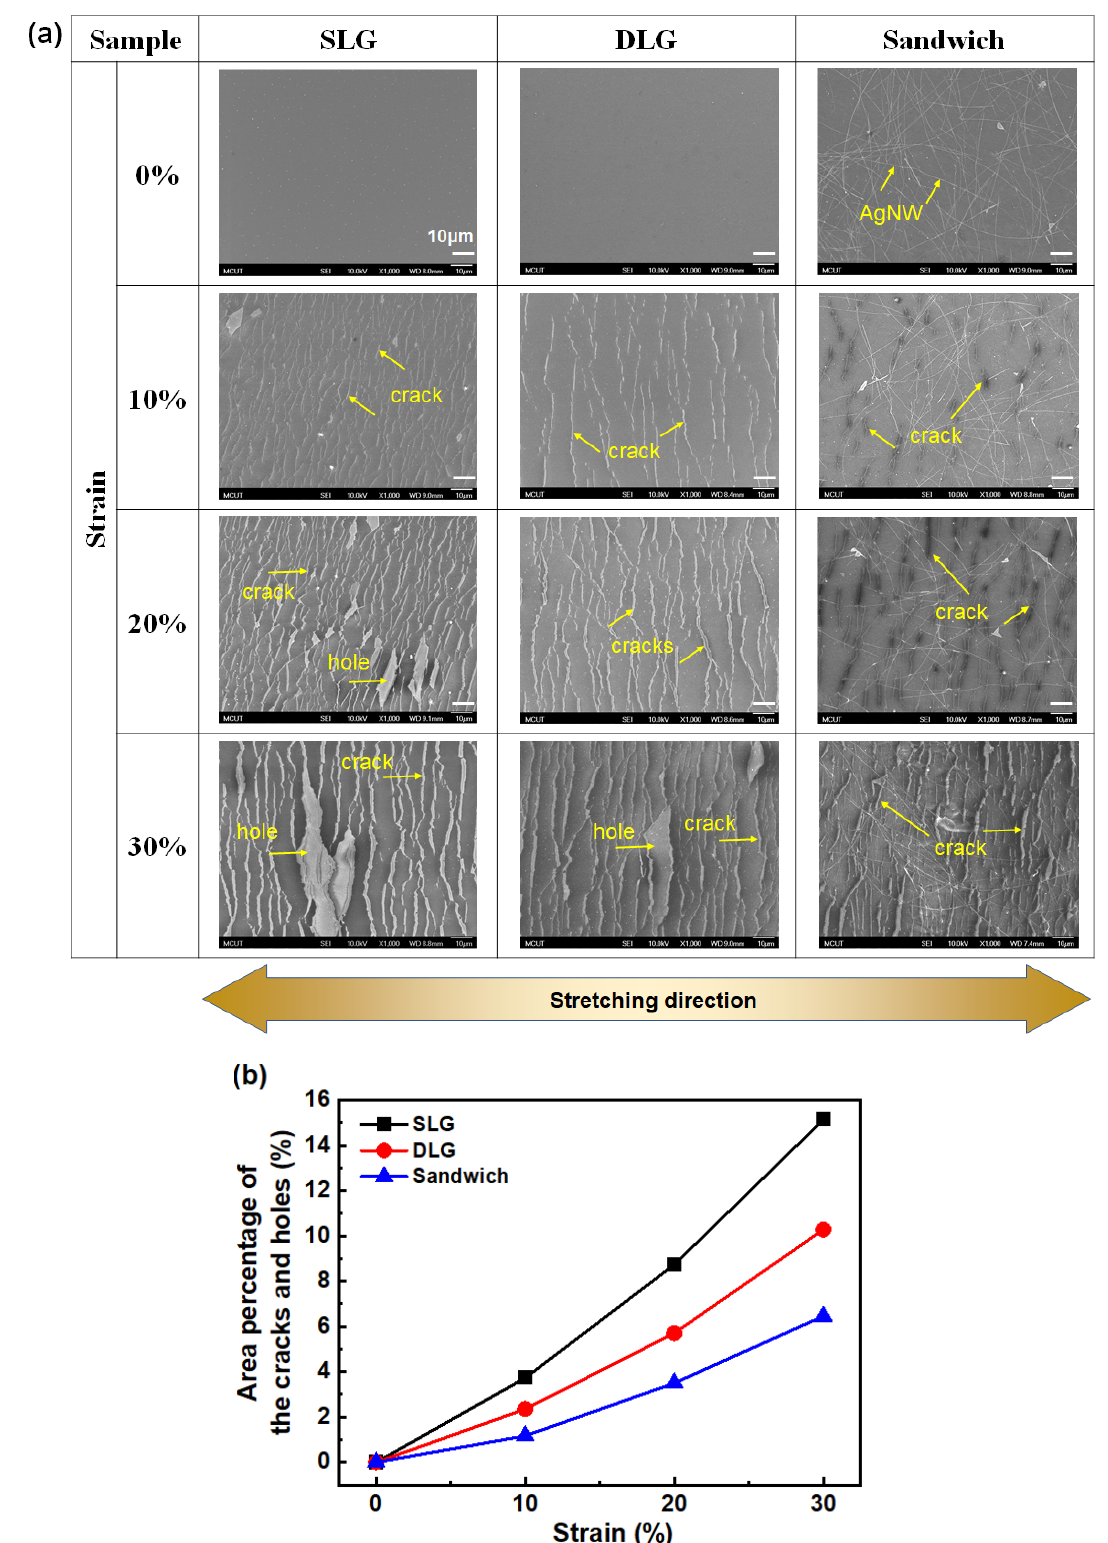
Figure 6. ( a ) SEM images and ( b ) area percentages of the SLG, DLG and sandwich structure under various tensile strain.